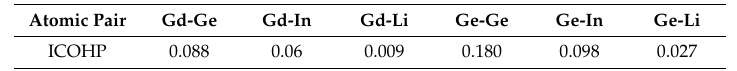
Table 4. ICOHP values (ev/bond) of the six selected interatomic interactions in the RE 2 In 1 − x Li x Ge 2